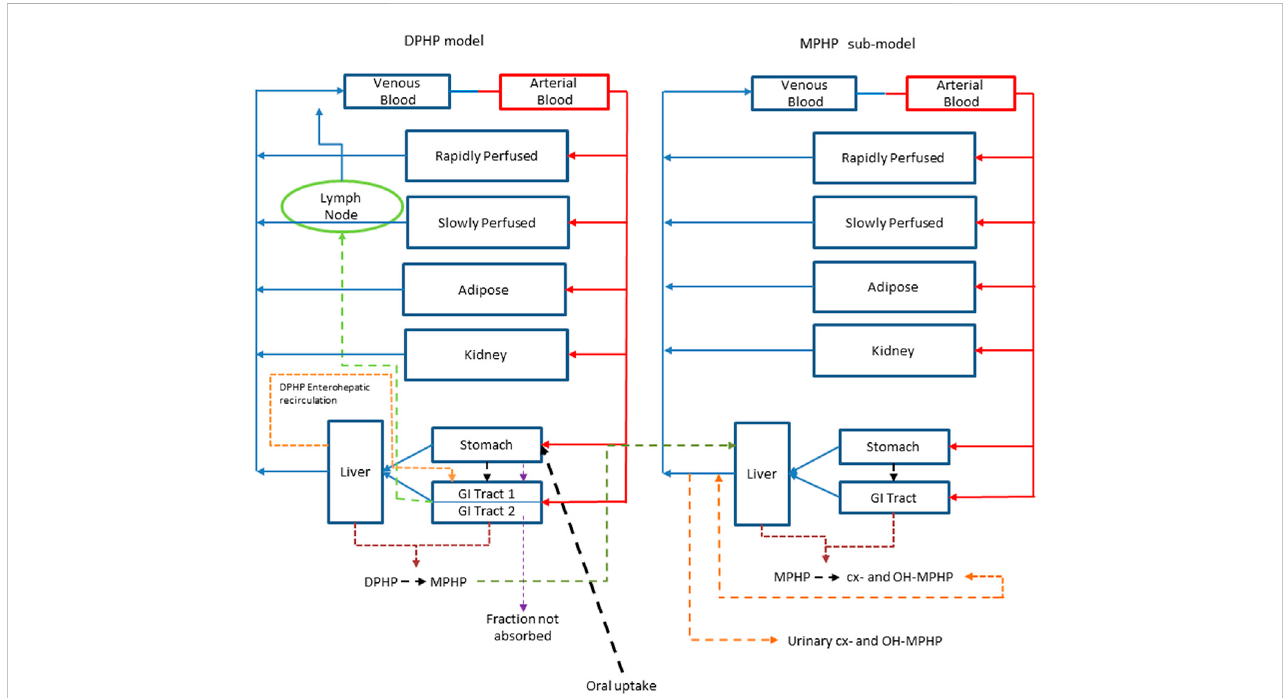
FIGURE 2 A schematic ofthemodelfor DPHP and sub-model for MPHP. The main model contained alymphatic compartment(- ---) which received aportion of oral dose from the stomach and GI tract. Urinary excretion of metabolites was described with a fi rst-order elimination rate constant ascribed to the sub-